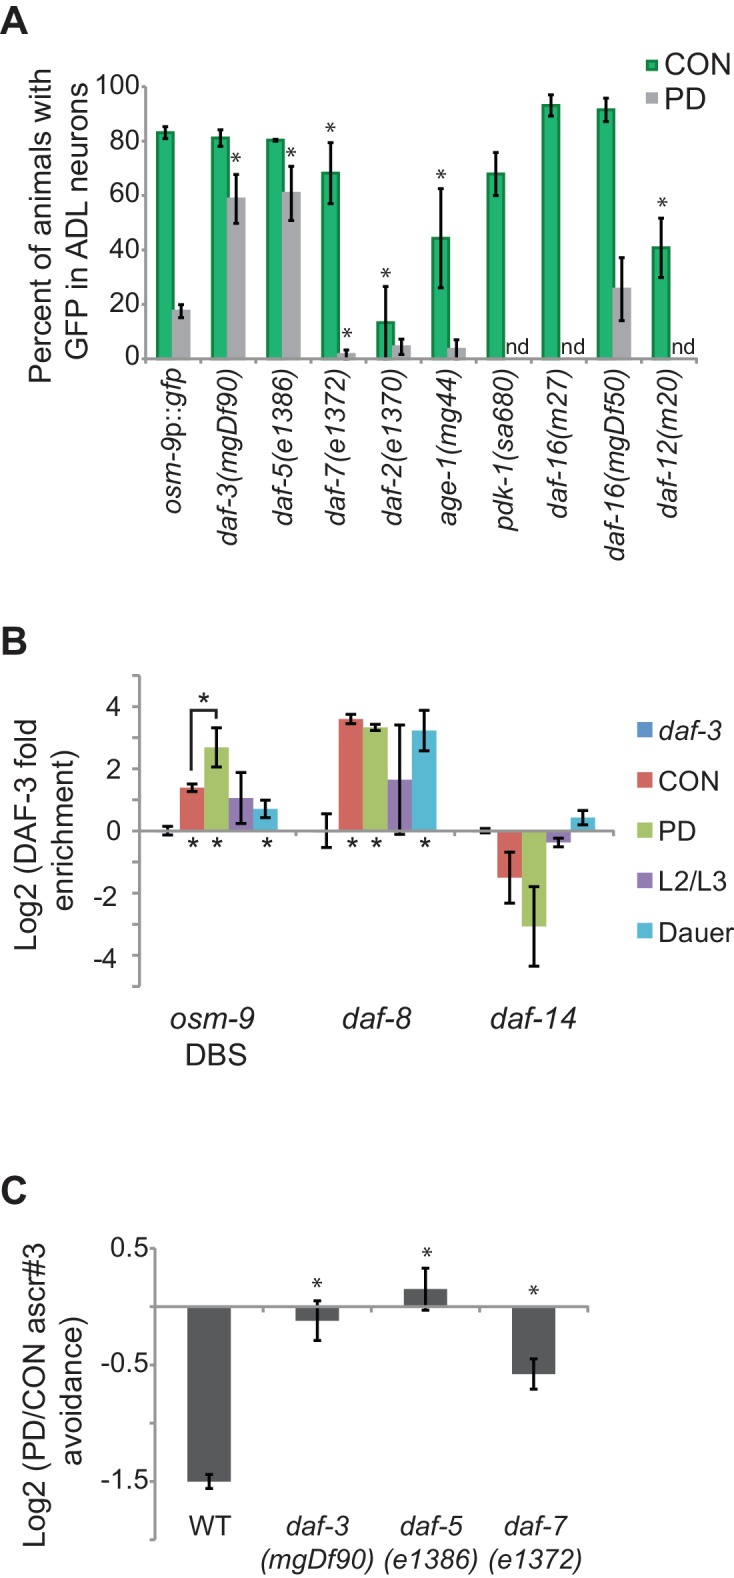
The TGF-β pathway regulates osm-9 expression in response to developmental history.(A) Percent ADL neurons expressing osm-9p::gfp in CON and PD adults in wild-type and strains carrying mutations in TGF-β and insulin signaling pathways. GFP expression for Mutation 2 in daf-3, daf-5, and daf-3; daf-5 mutants is found in Figure 3—figure supplement 1. N ≥ 3 trials; n ≥ 60 animals (Figure 3—source data 1). * indicates CON or PD significantly different from wild-type; One-way ANOVA with LSD posthoc correction, p<0.05. n.d., not determined. (B) Log2 normalized enrichment of DAF-3 SMAD binding to the osm-9 DAF-3 binding site (DBS) in C. elegans developmental stages. daf-8 and daf-14 are positive and negative controls, respectively. Bar graph represents IP-qPCR data, normalized to DAF-3 binding to actin act-2 promoter (Park et al., 2010). N ≥ 2 biologically independent trials (Figure 3—source data 2). * indicates enriched over background (daf-3 CON) or between CON and PD as indicated, p<0.05, Student’s t-test. (C) Log2 PD/CON ratio of ascr#3 avoidance behavior in wild-type and strains carrying mutations in TGF-β pathway genes. Data for controls is found in Figure 3—figure supplement 2. * indicates significantly different from wild-type; One-way ANOVA with LSD posthoc correction, p<0.05 (Figure 3—source data 3). All error bars represent S.E.M.DOI:
http://dx.doi.org/10.7554/eLife.11642.01610.7554/eLife.11642.017Figure 3—source data 1.Spreadsheet containing percentages of animals expressing osm-9p::gfp in ADL neurons in strains carrying mutations in TGF-β and insulin signaling genes.DOI:
http://dx.doi.org/10.7554/eLife.11642.01710.7554/eLife.11642.018Figure 3—source data 2.Spreadsheet containing DAF-3 enrichment values in wild-type CON, PD, larval L3, and dauer animals.DOI:
http://dx.doi.org/10.7554/eLife.11642.01810.7554/eLife.11642.019Figure 3—source data 3.Spreadsheet containing PD/CON ascr#3 avoidance ratios for strains carrying mutations in TGF-β and insulin signaling genes.